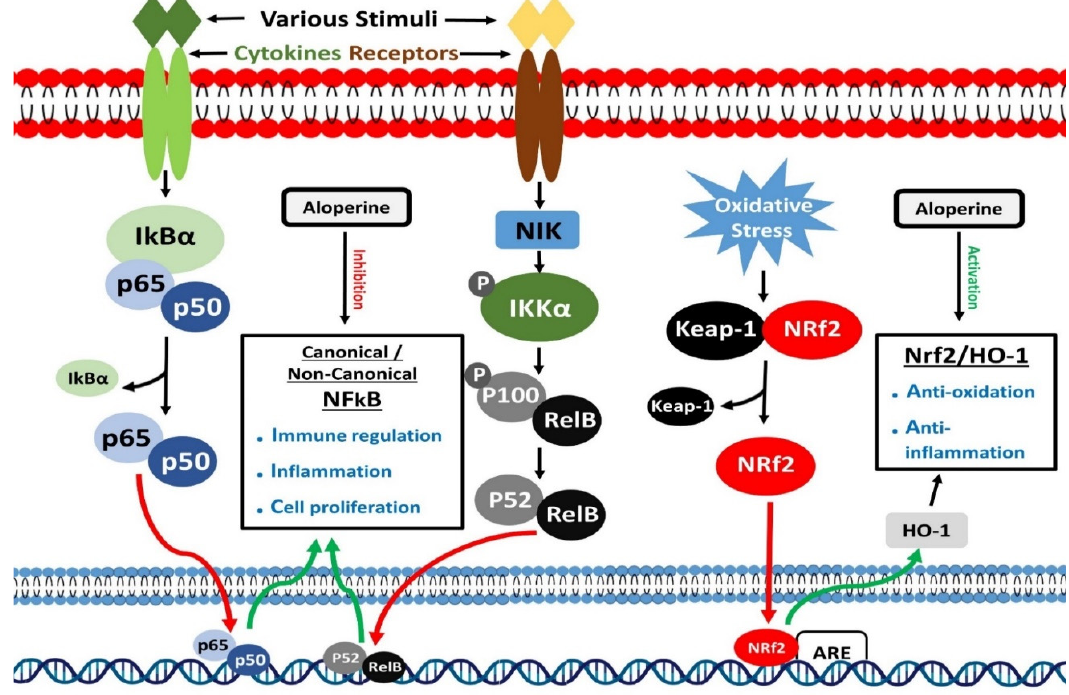
Figure 4. Modulatory effects of aloperine on NF- κ B and Nrf2 signaling.